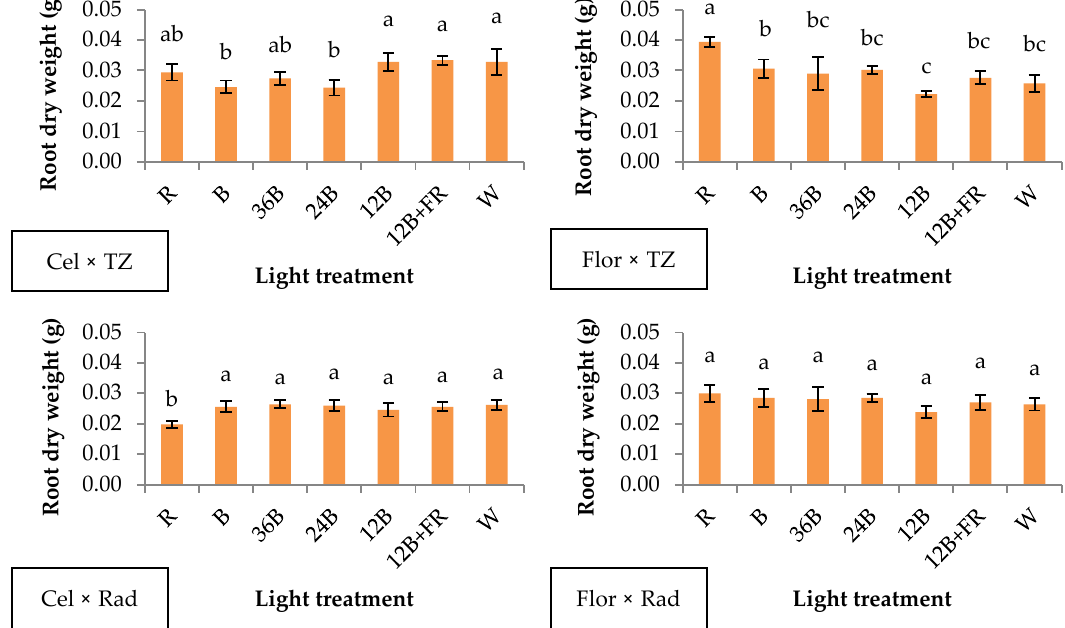
Figure 4. Root dry weight of grafted watermelon seedlings derived from four watermelon × interspecific squash genotype combinations, and after illumination by seven light treatments during healing. Bars ( ± SE) followed by different letters are significantly different ( p ≤ 0.05).